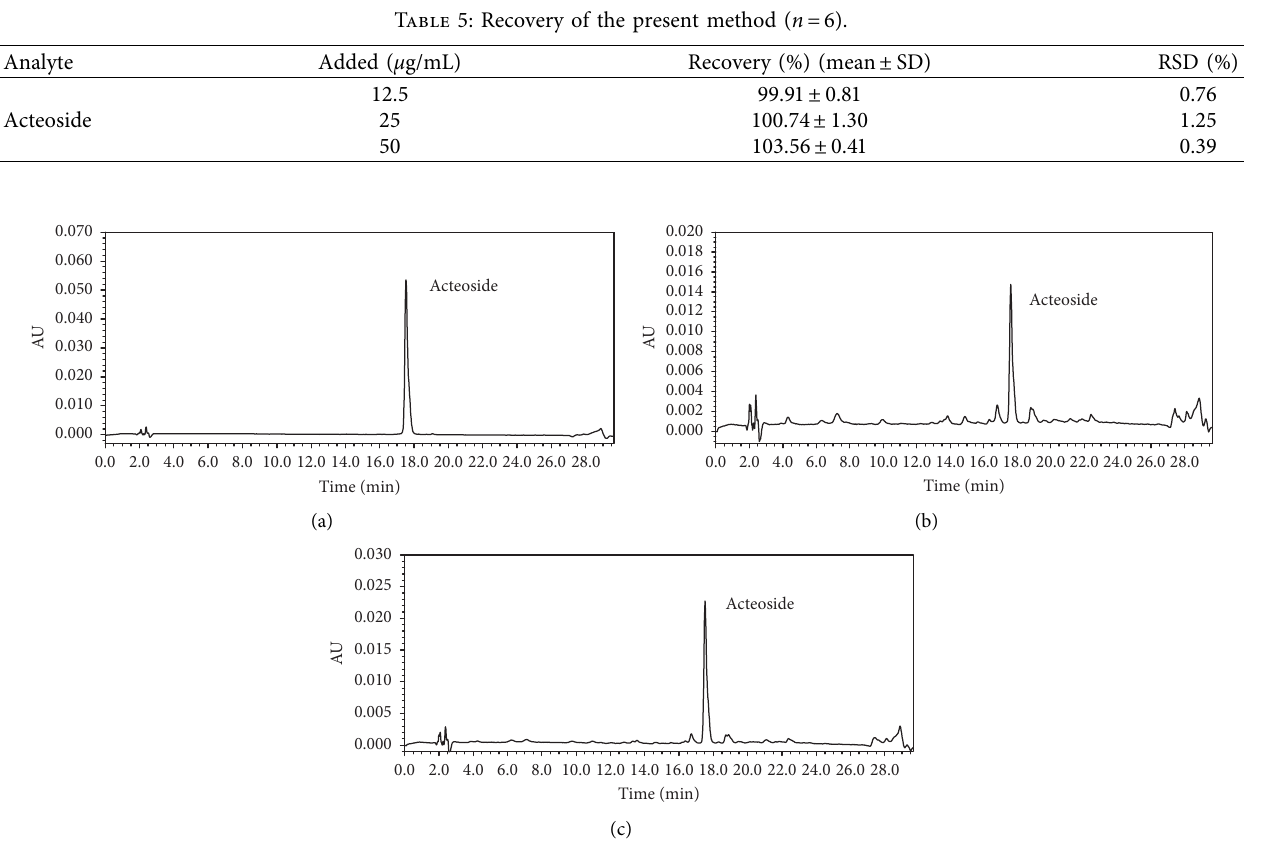
Figure 2: Typical high-performance liquid chromatography chromatograms of (a) acteoside standard (100 μ g/mL), (b) Osmanthus fragrans leaf (0.2mg/mL), and (c) Osmanthus fragrans var. aurantiacus